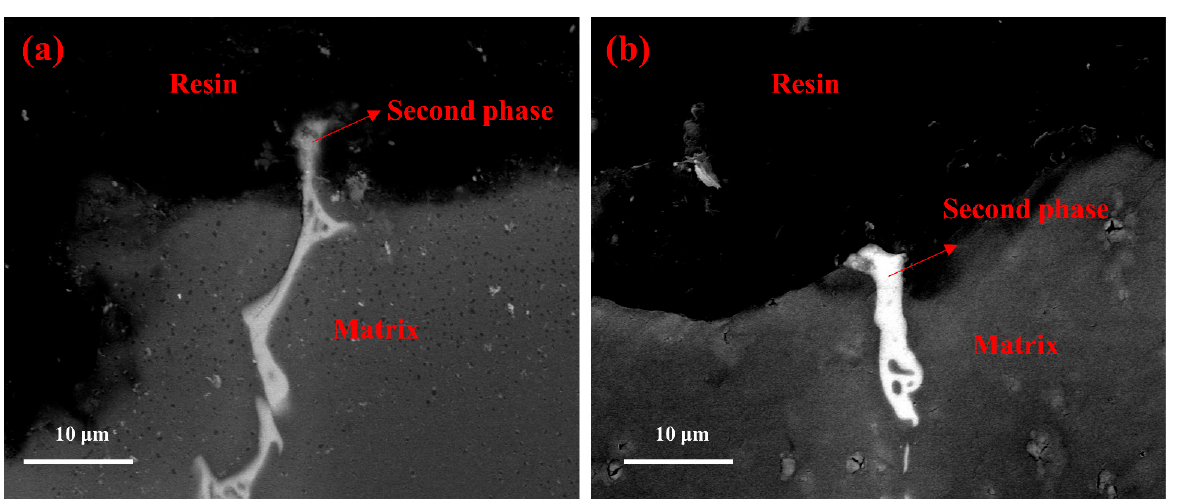
Figure 6. The cross-section morphology of WE43 immersed in NaCl ( a ) and Na 2 SO 4 ( b ) for 10 h.